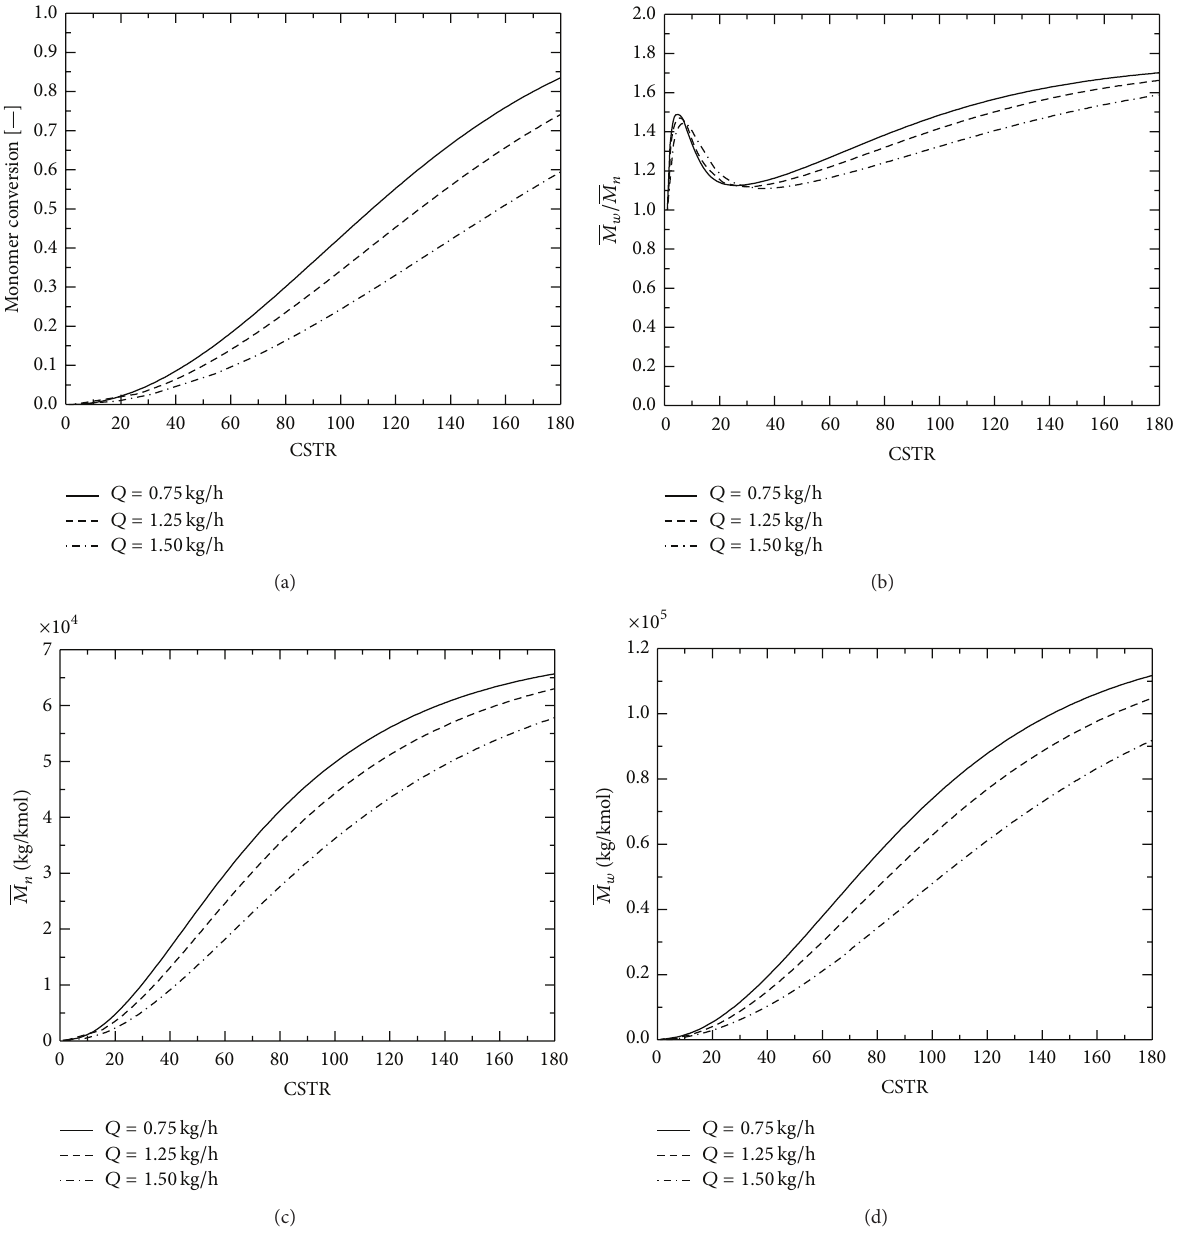
Figure 6: Effect of the mass flow rate ( 𝑄 ) on (a) the monomer conversion, (b) polydispersity index, (c) the weight average molecular number 𝑀 𝑛 , and (d) the weight average molecular weight